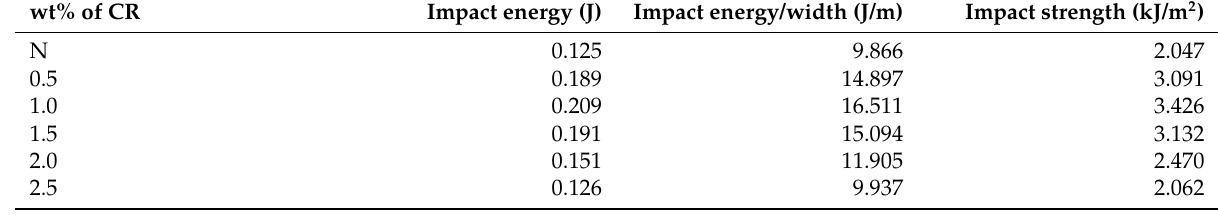
Table 12: Impact strength, impact energy and impact energy/width for various composition of CFR based composite.